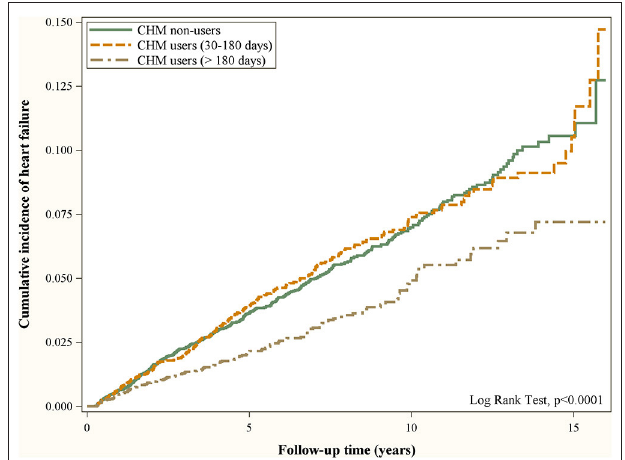
FIGURE 2 | Cumulative incidence of heart failure in hypertensive patients with and without CHM treatment using the Kaplan–Meier method.